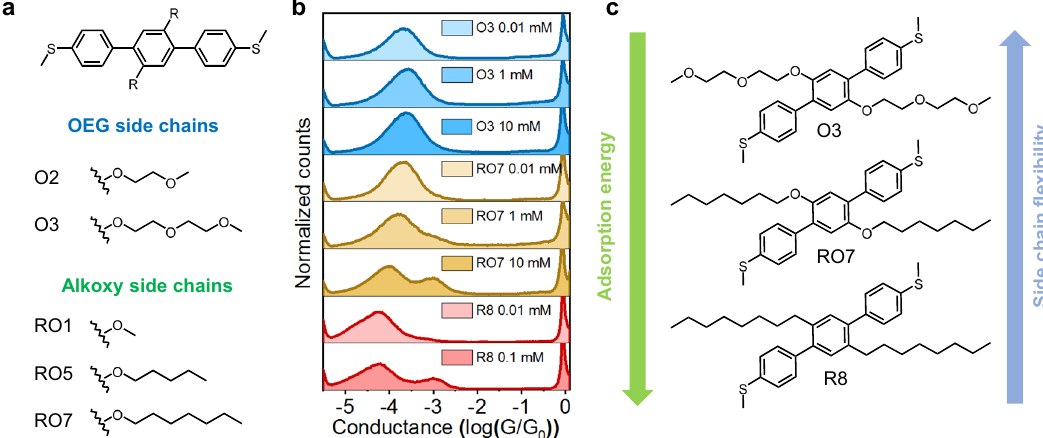
Fig. 5 Single-molecule characterizations of terphenyl derivatives with OEG and alkoxy chains. a Chemical structures of terphenyl derivatives with OEG and alkoxy chains. b Concentration-dependent study of O3, RO7, and R8. c Differences of fl exibility and adsorption free energy between O3, RO7, and